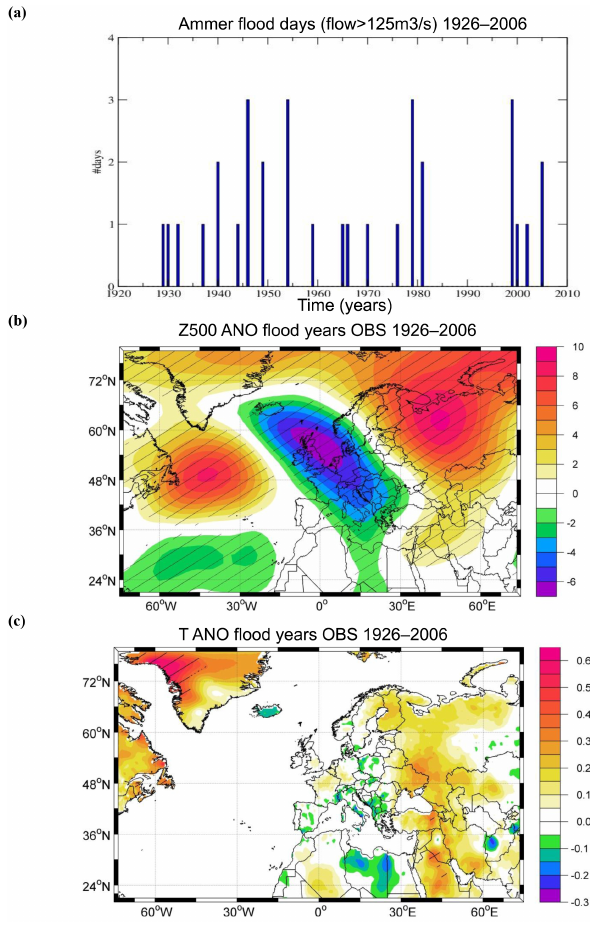
Figure 5. (a) Observed River Ammer flood frequency (daily dis- charge higher than 125m 3 s − 1 ) and (b) composite map of Z500 and (c) air temperature anomalies for flood years. Hatched regions: anomalies significantly different from zero (90% level). Units: Z500 (m) and T ( ◦ C).